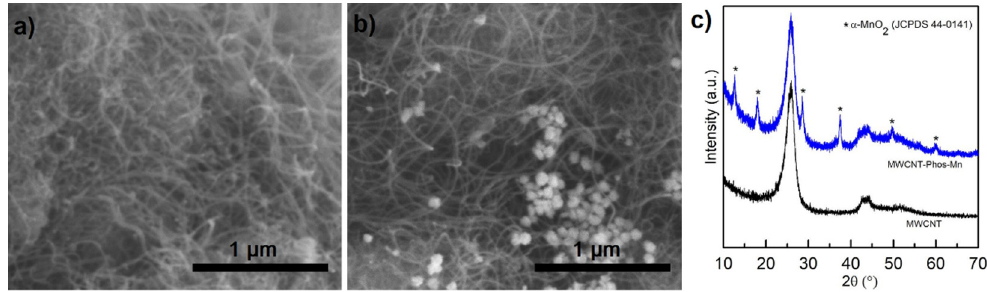
Figure 2. SEM images of MWCNT ( a ) and MWCNT–Phos–Mn ( b ) and their XRD patterns ( c ).